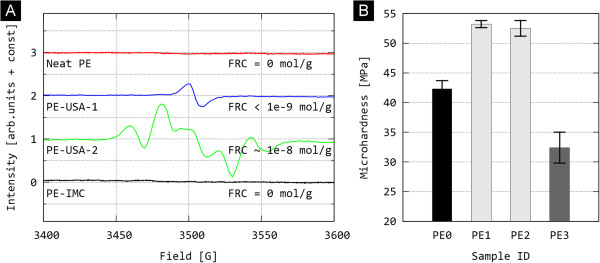
ESR spectra (A) and MH values (B) of new, unused UHMWPE components PE0–PE3 (see also Table2
).